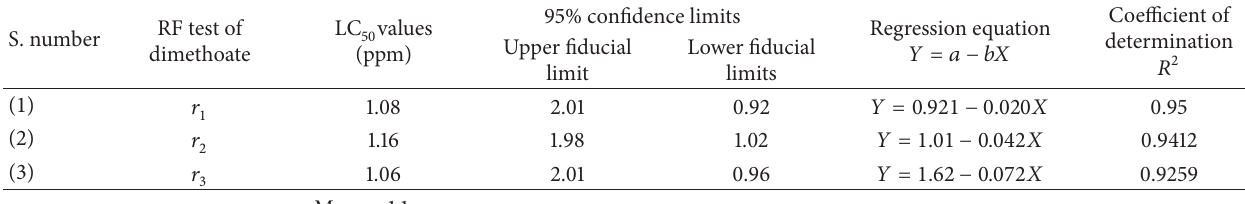
Table 1: Cumulative LC 50 values of range finding (RF) tests of dimethoate.